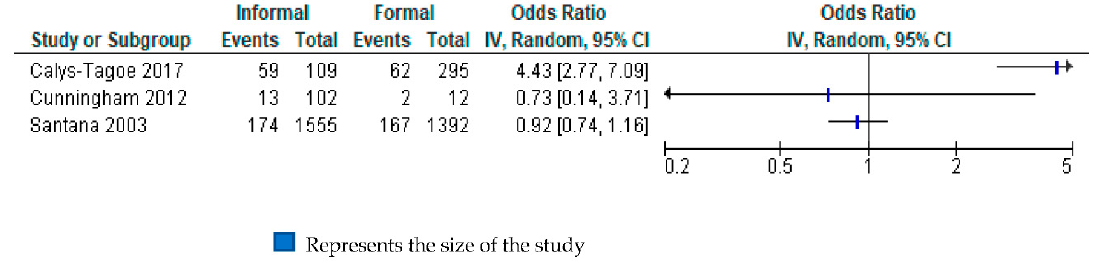
Figure 4. Forest plot assessing non-fatal occupational injuries in informal economy, compared with formal economy work-